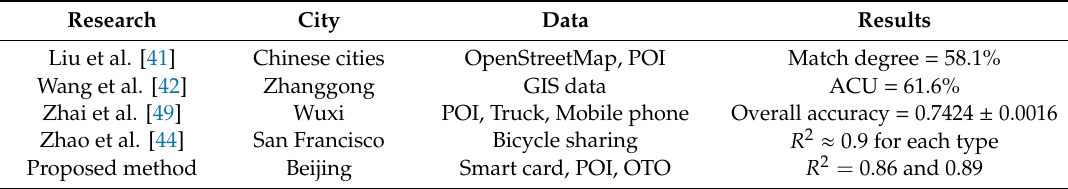
Table 6. Comparation with Other